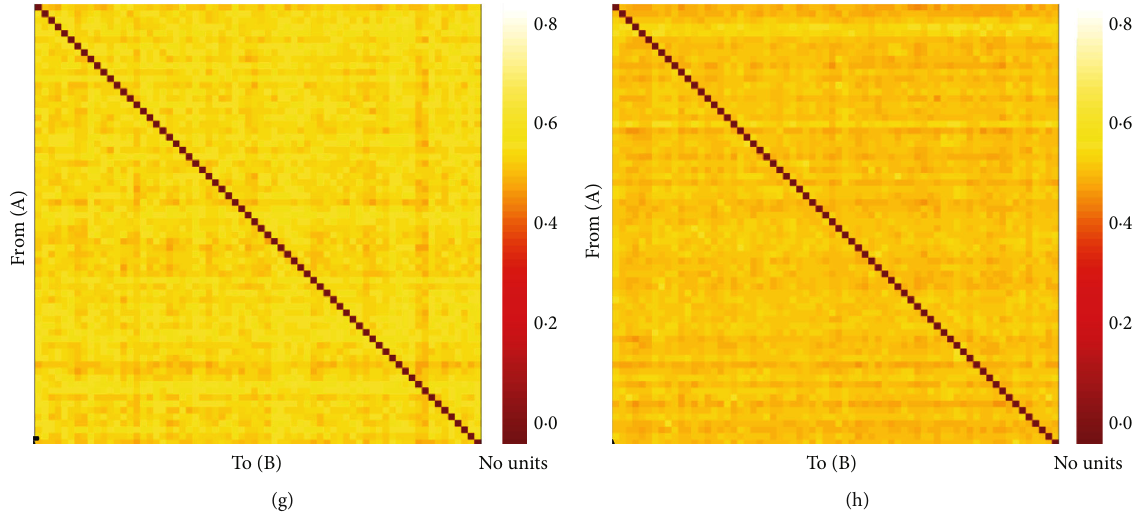
Figure 8: PTE matrix diagram and circos diagram. (a, b) Delta band PTE. (c, d) Theta band PTE. (e, f) Alpha band PTE. (g, h) Beta band PTE. PTE of delta band ( Z = − 42 : 68 , P < 0 : 01 ), theta band ( Z = − 56 : 79 , P < 0 : 01 ), alpha band ( Z = − 35 : 11 , P < 0 : 01 ), and beta band ( Z = − 63 : 74 , P < 0 : 01 ) is statistically signi fi cant. (PTE: phase transfer entropy).